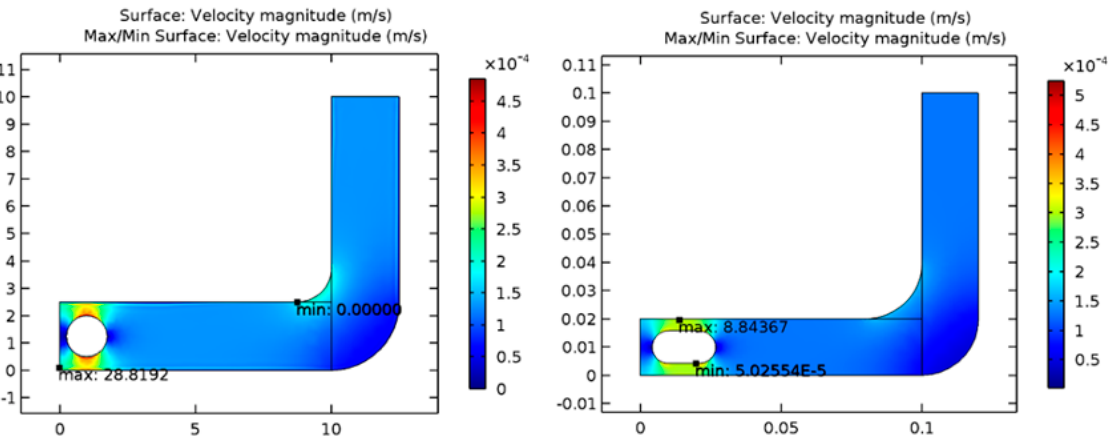
Figure 13. Comparison of velocity for the GI tract’s spherical ( left ) and capsule ( Right ) geometries.